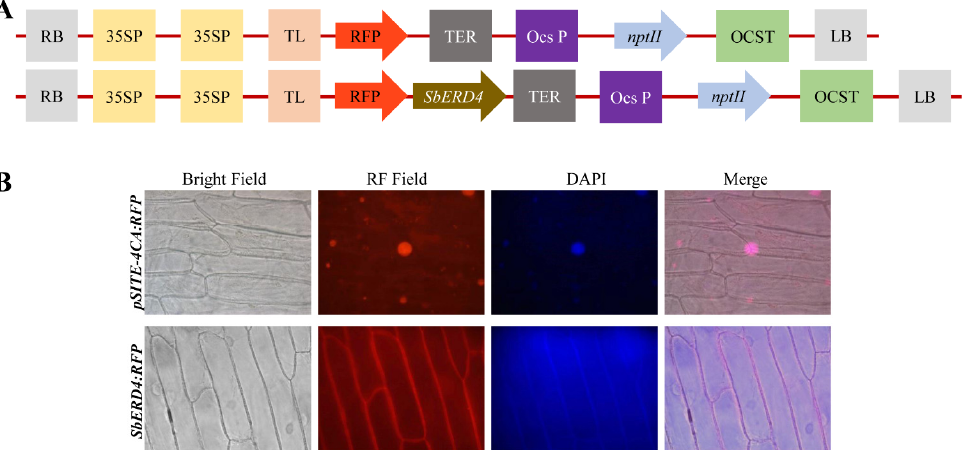
Figure 1. Subcellular localization study of SbERD4 protein. ( A ) Schematic illustration of vectors pSITE-4CA:RFP and gene construct SbERD4:RFP , and ( B ) Onion epidermal cells transformed with SbERD4:RFP fusion construct and vector alone ( pSITE-4CA:RFP ).